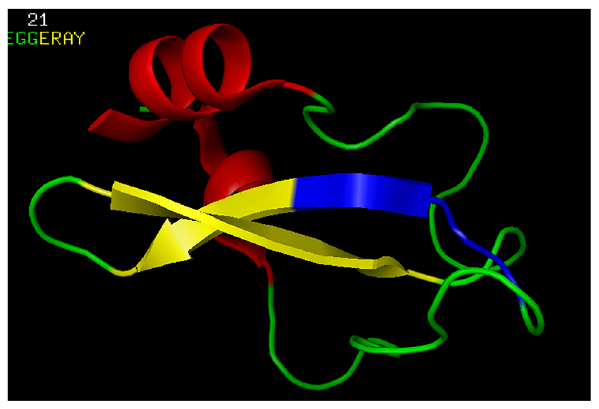
Figure 4: PDB entry 1TCP: the tick anticoagulant peptide (TAP), depicted with PyMol. The blue-colored section correspond to the GGERA prefix: GG preceeding the first three residues, ERA, in the 𝛽